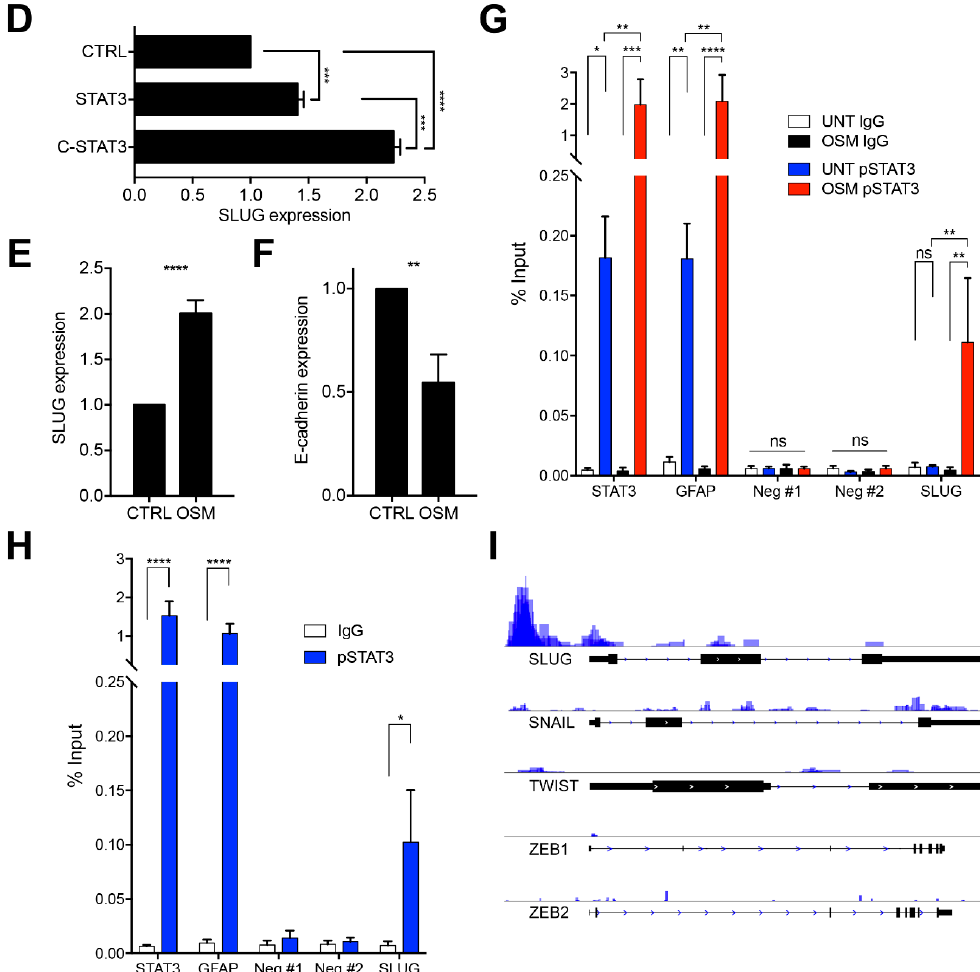
Figure 3. SLUG is the primary direct transcriptional target of STAT3 in BTSC (see also Figure S5). ( A ) Box and whiskers graph (min to max) representing SLUG expression measured by qPCR in 12 BTSCs (as detailed in section 4.1) treated with JAK3 inhibitor (R333) and ( B ) representative western blot quantified relative to loading control. ( C ) Representative western blot (with quantification values relative to loading control) showing activated STAT3 (pSTAT3-Y705) and SLUG protein levels in BT67 24 hours post epidermal growth factor (EGF), leukemia inibitory factor (LIF), and oncostatin M (OSM) treatments with or without concurrent inhibition of STAT3 with direct STAT3 inhibitor STATTIC (10 µM). ( D ) Bar graph of SLUG expression measured by qPCR in empty vector, wild-type STAT3, or constitutive STAT3, overexpressing BT124. RT-qPCR data representing ( E ) SLUG and ( F ) E-cadherin expression following OSM treatment (10 ng/mL) in BT67. Positive controls (STAT3 and GFAP), negative controls and SLUG enrichment results from ChIP-PCR experiments performed ( G ) on BT67 in growth factor-free media with or without OSM or ( H ) on BT50, BT67, BT69, BT89, BT94, BT147 grown in standard BTSC culture condition ( + EGF, + FGF). ( I ) Histograms representing binding of STAT3 on the promoter of SLUG, SNAIL, TWIST, ZEB1, and ZEB2 from whole genome ChIP-seq experiments performed on the same 6 BTSC lines (BT50, BT67, BT69, BT89, BT94, BT147) maintained in standard BTSC culture condition ( + EGF, + FGF). ( D – H ), SEM, ns. p > 0.05; * p < 0.05; ** p < 0.01; *** p < 0.001; **** p <